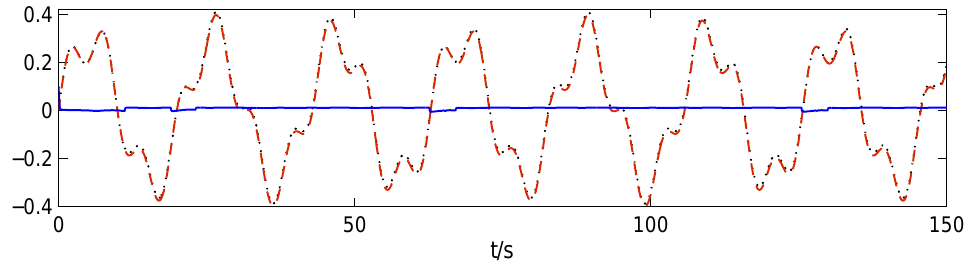
Figure 6. Tracking performance of output y